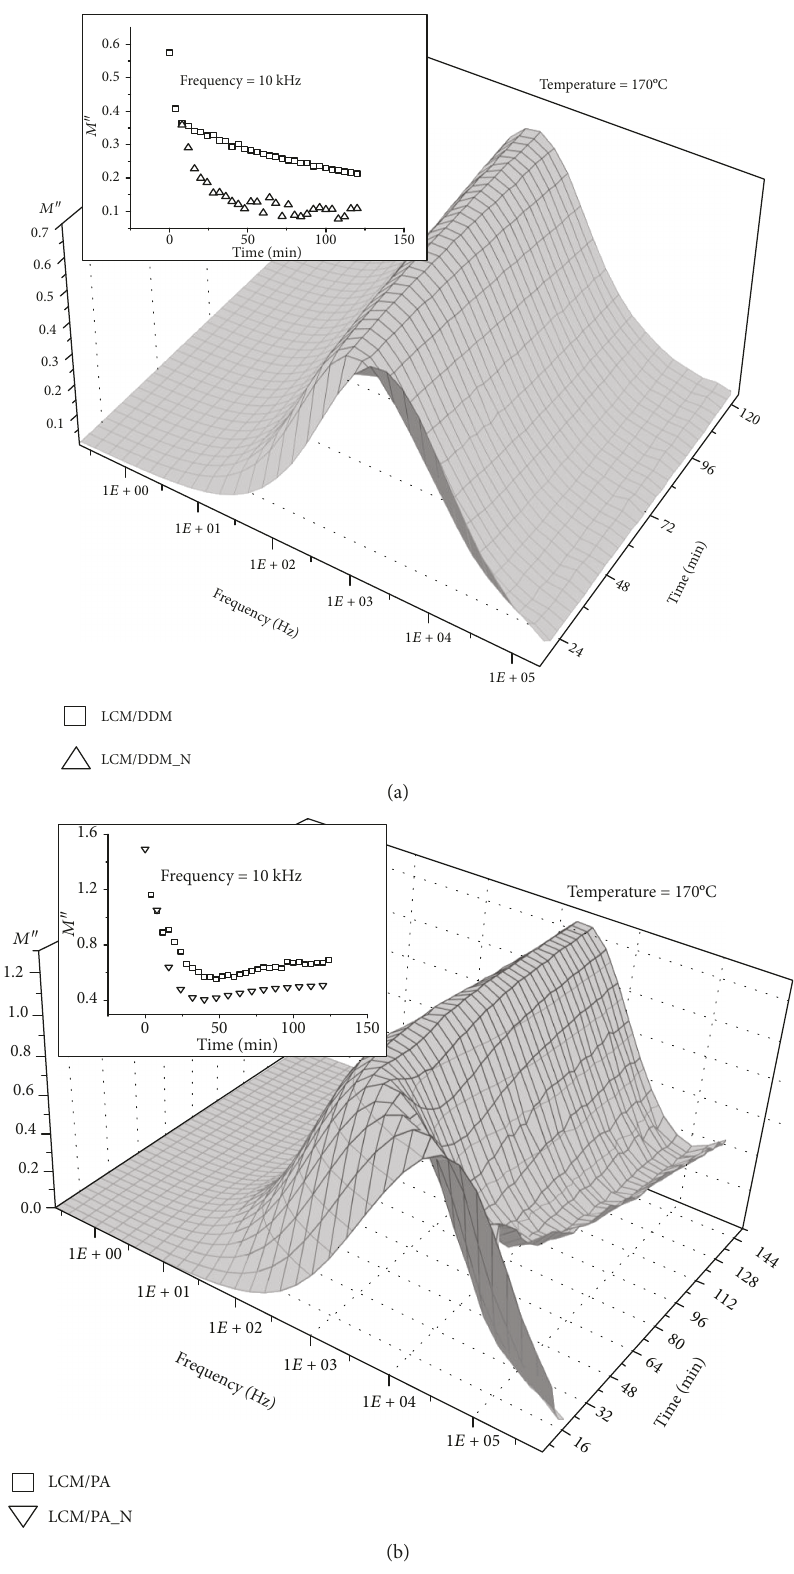
Figure 2: Isothermal curing of the epoxy resin at T =170 ° C, in the electric modulus representation. Imaginary part of the electric modulus plotted versus time in a wide frequency range: (a) curing with the aromatic amine (DDM); (b) curing with pimelic acid (PA). Insets: modulus evolution with time at one speci fi c frequency, for mixtures cured with and without nano fi